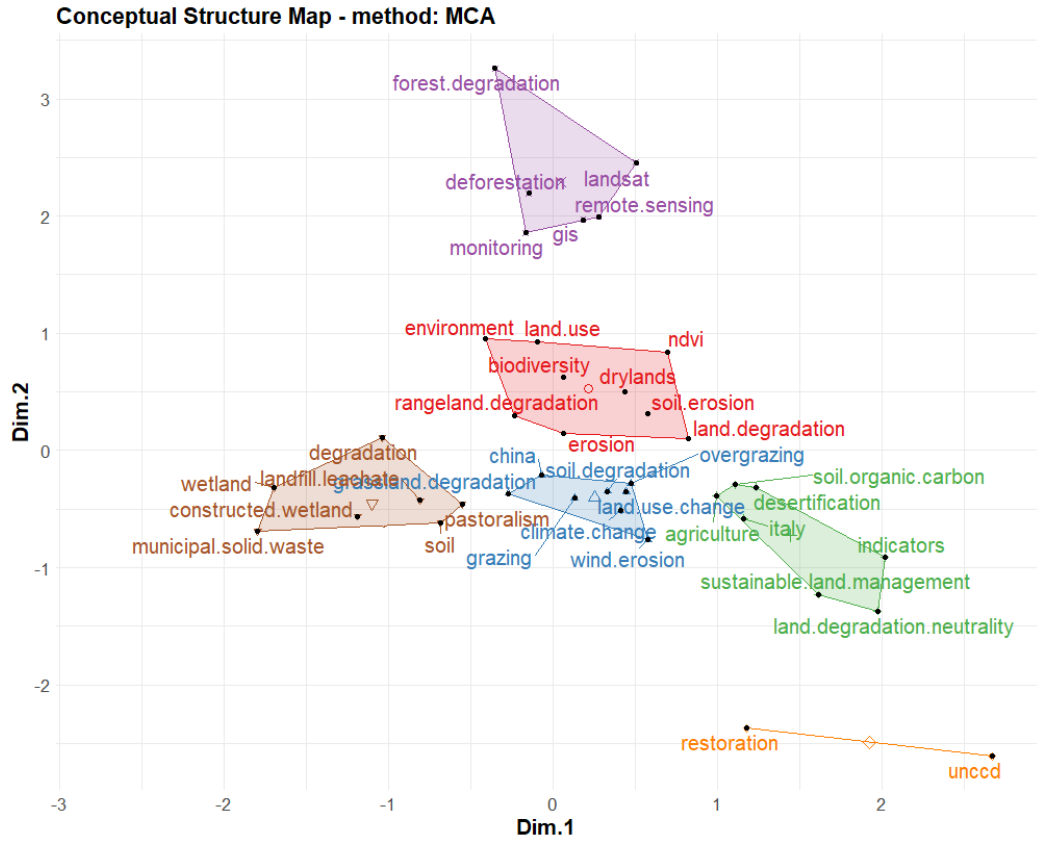
Figure 11. Multiple correspondence analysis (MCA) of high-frequency key words in the field of land degradation.